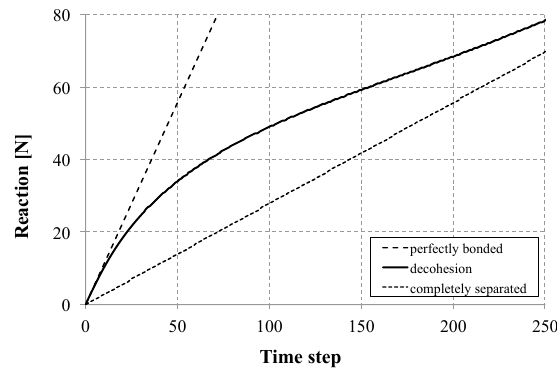
Figure 22: 3D thin-walled triangular laminates: reaction- displacement global